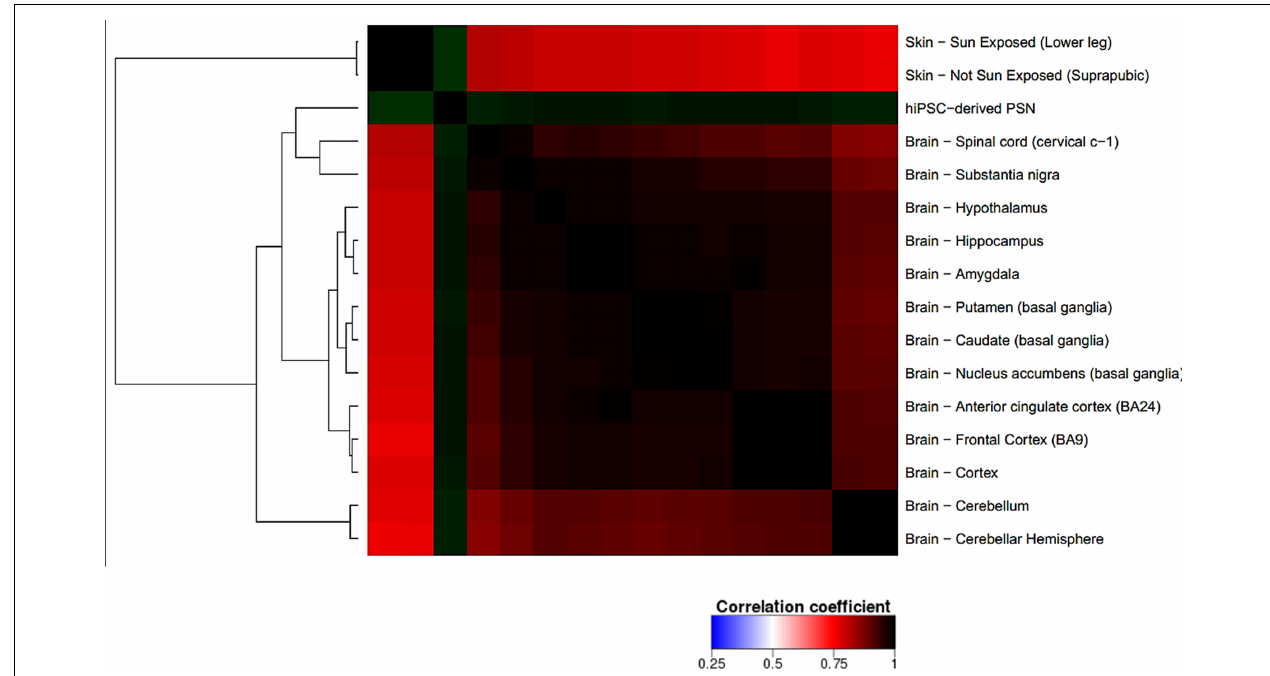
FIGURE 8 | Correlation heatmap comparing PSN transcriptional profile with human GTEx gene expression data of neuronal and skin tissues. Heatmap was generated using Heat ∗ seq tool (Devailly et al., 2016). using average RNA-Seq data from six distinct biological replicates of PSNs cultures, showing higher scaled correlation with neuronal human tissues such as hypothalamus, amygdala, frontal cortex, hippocampus (scaled correlation 0.950; 0.936; 0.935, and 0.935 respectively).